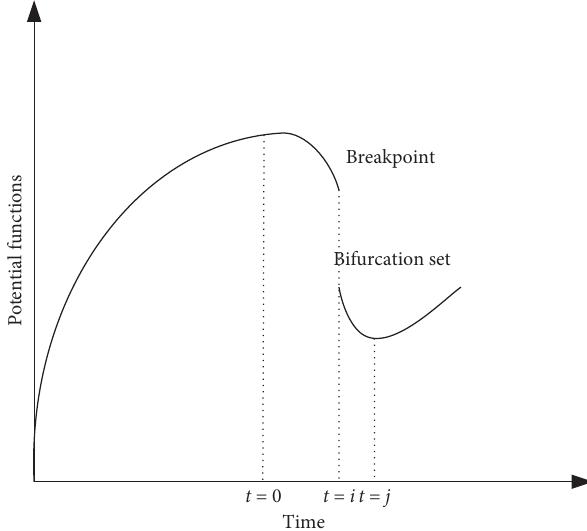
Figure 1: The change graph of the potential function of occasional